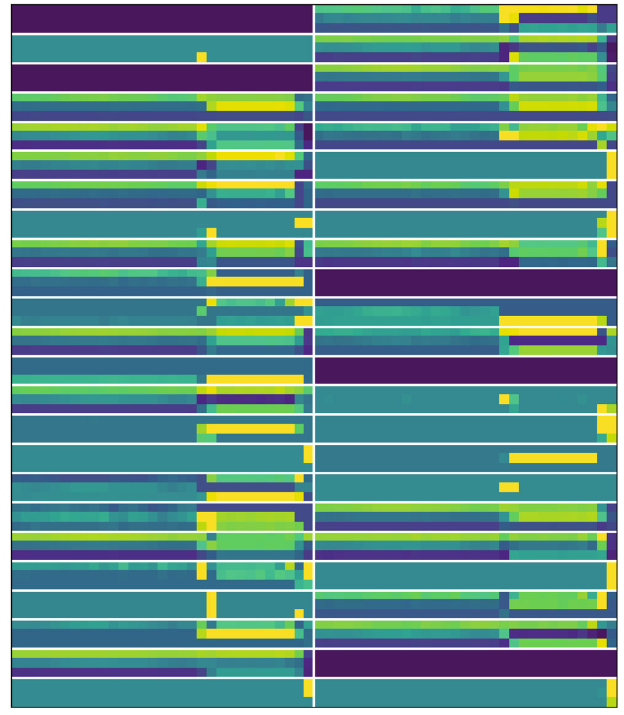
Figure 16: Feature visualization of the second convolution layer (48 in total).